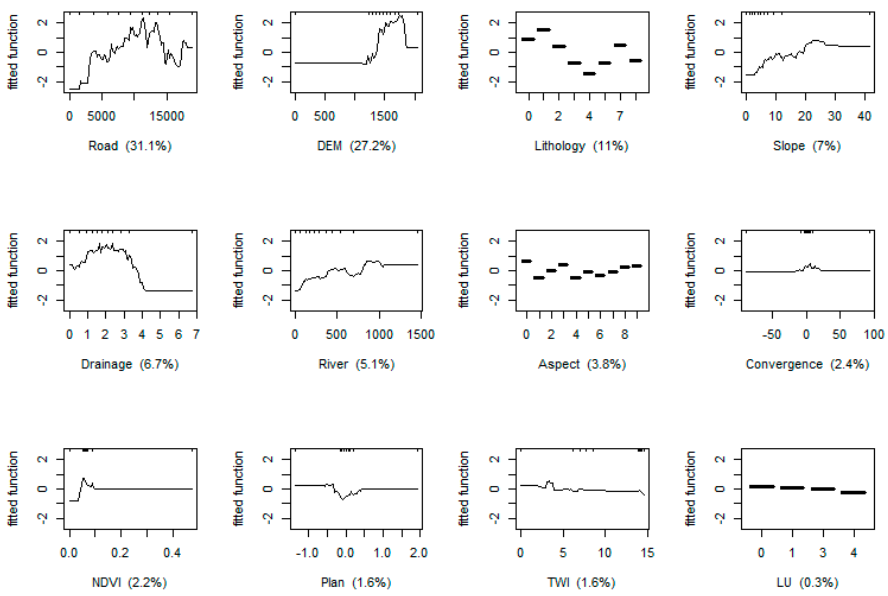
Figure 6. Relative influence of effective conditioning factors in boosted regression tree (BRT) model.